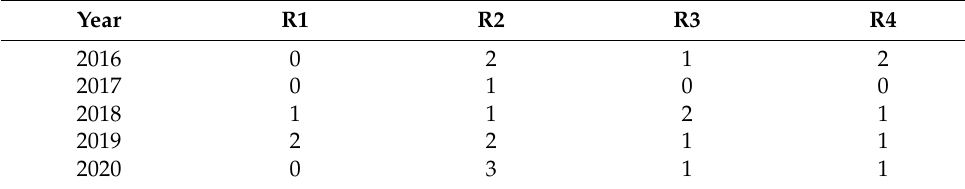
Table 9. Actual route selections of oversize cargo transportation.